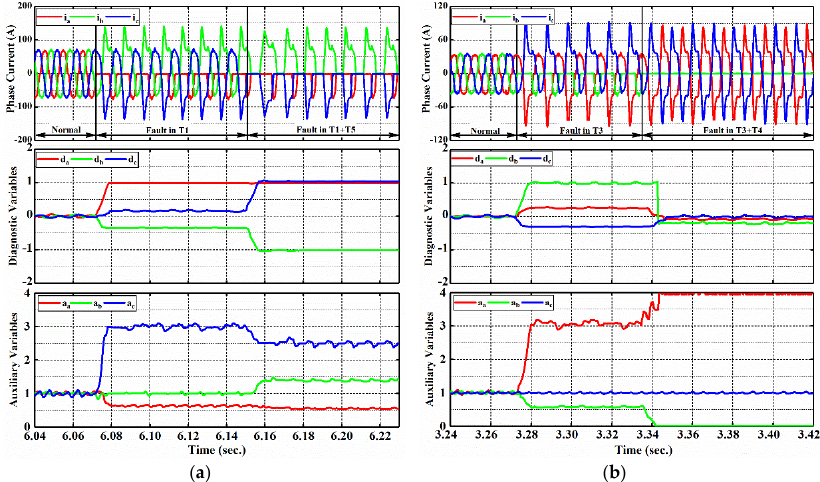
Figure 7. Experimental results about waveforms of phase currents, diagnostic variables and auxiliary variables for referential speed of 360 rpm: ( a ) Open circuits in T1 and T5 under 100% of rated torque; ( b ) open circuits in T3 and T4 under 60% of rated torque.